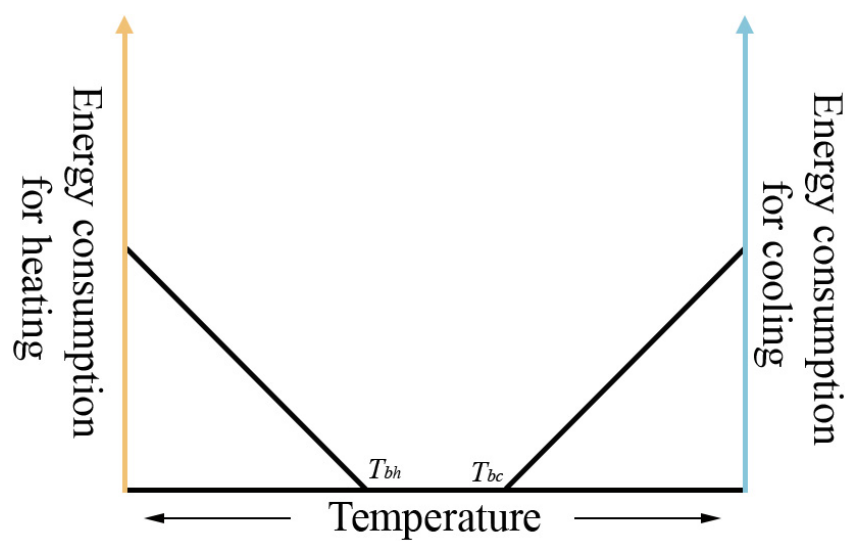
Figure 1. Schematic diagram of the relationship between energy consumption and temperature for heating and cooling. T bh and T bc are the baseline temperature for heating and cooling, respec- tively.